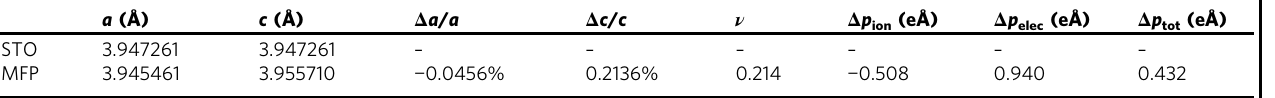
Table 3 Lattice parameters of the MFP phase obtained by means of